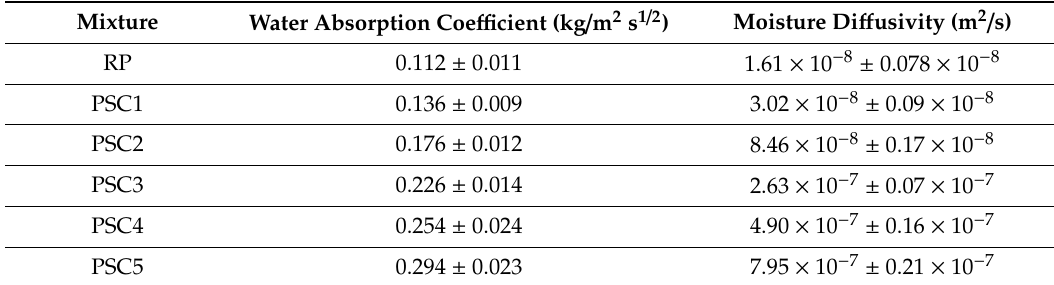
Table 5. Hygric properties of studied plasters.